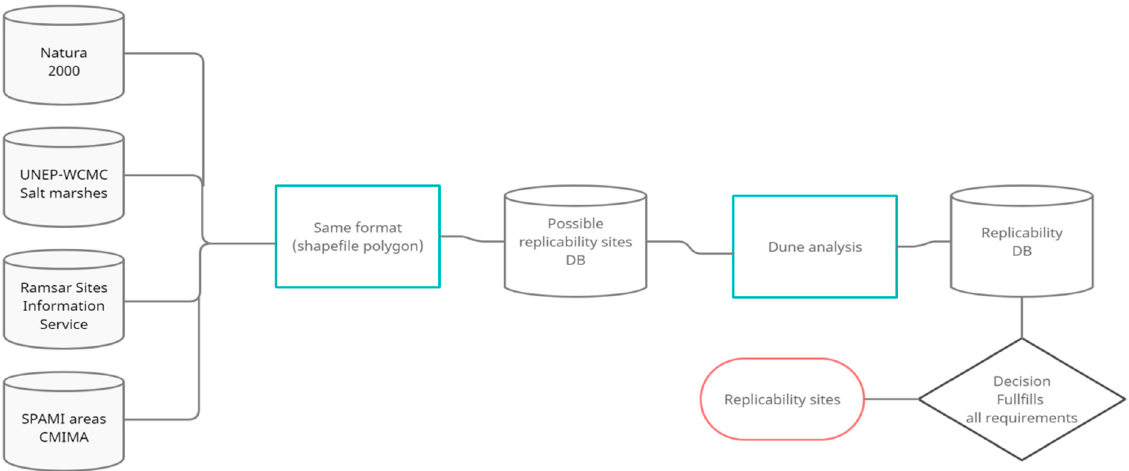
Figure 2. Conceptual scheme of the methodology followed. Source: ewn